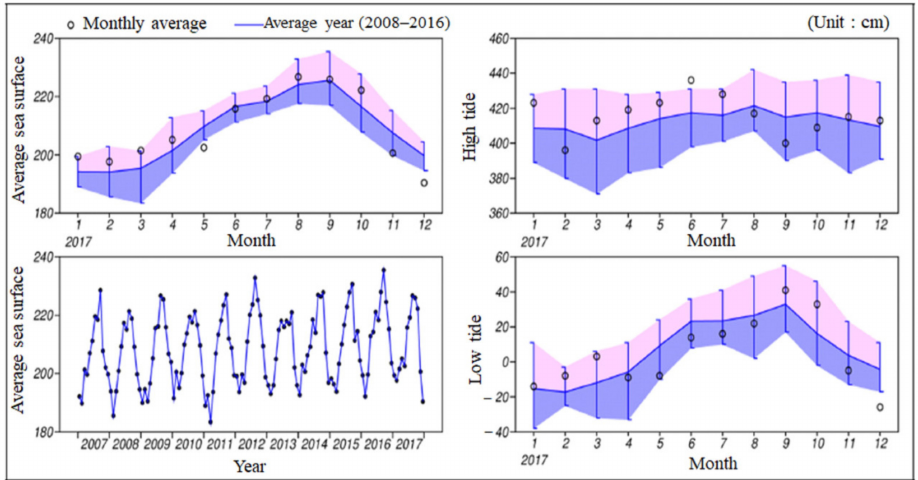
Figure 2. Monthly average tidal status, Southern sea,